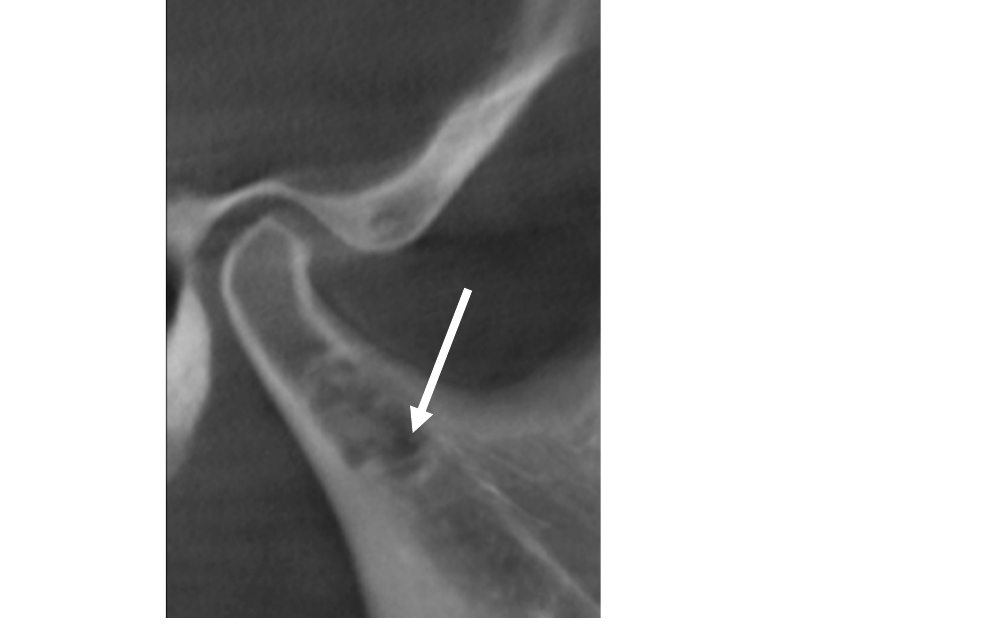
Figure 5. Postoperative cone-beam CT performed 6 months after surgery. Bone regeneration is evident, and only a small central area of lower bone density is not detectable (white arrow).